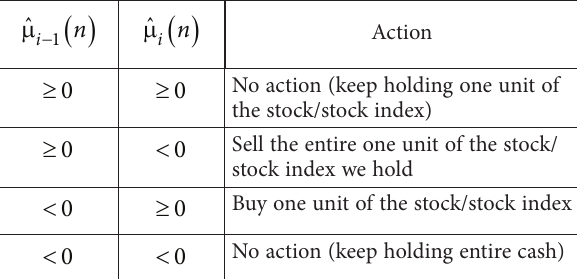
Table 1. Our trading strategy from Day 2 to the second last